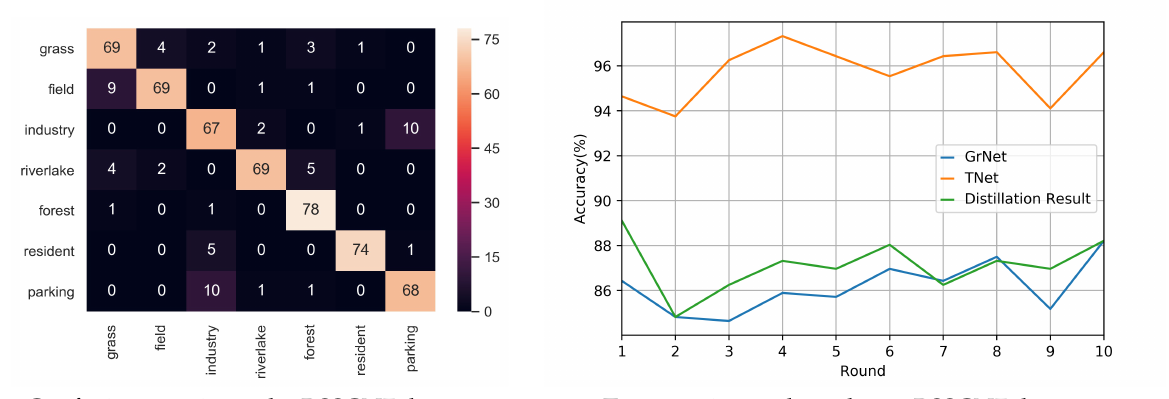
Figure 11. The confusion matrices and ten experimental results of model trained on the UCM, SIRI-WHU and RSSCN7